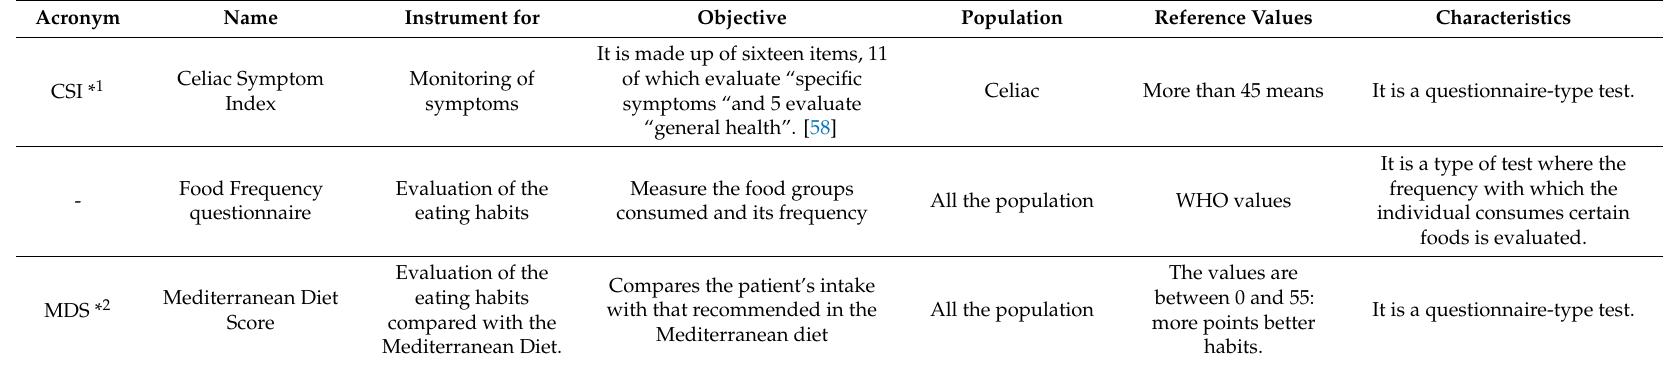
Table 3. Diagnostic tests (noninvasive) / description of the di ff erent analyses and tests performed on patients and for what they are